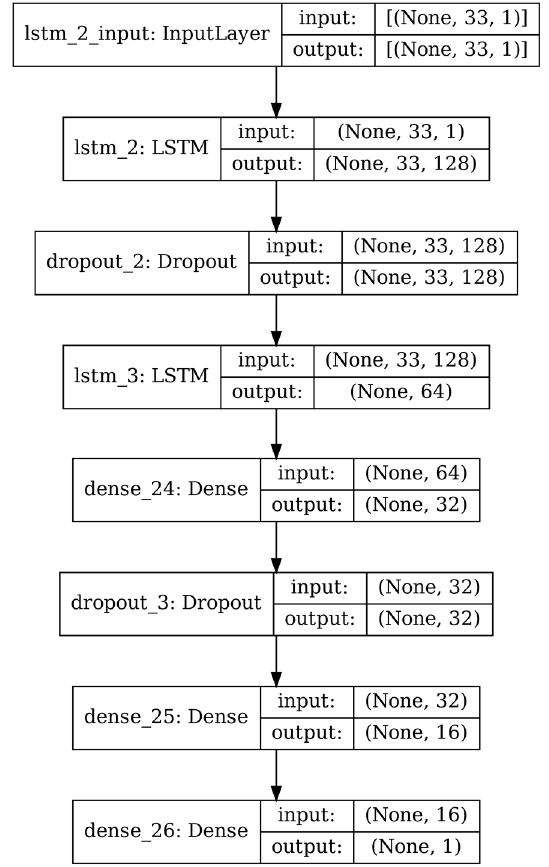
Figure 4. Developed DBoTPM model for predicting botnet